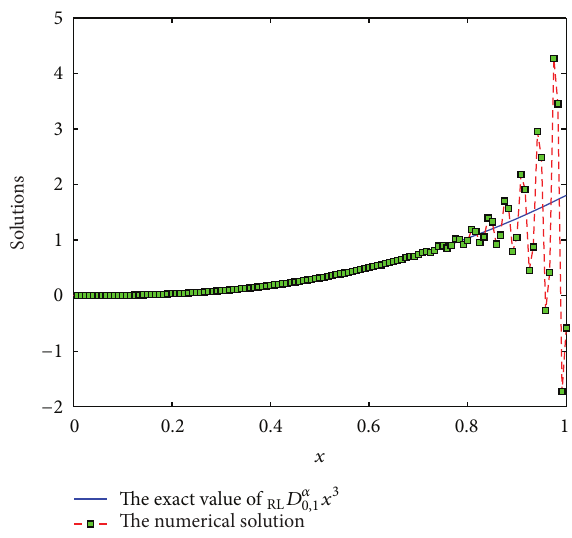
𝑥 3 and numerical solution of 𝐷 𝛼 0,1 RL